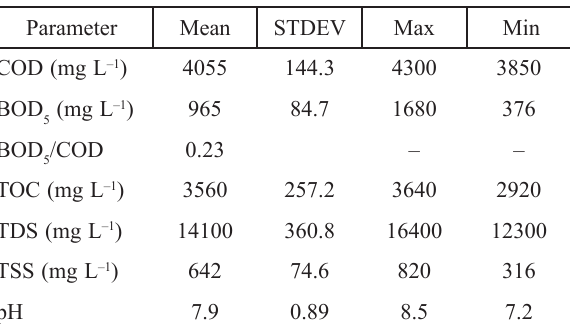
Table 1 – Characteristics of raw saline oily wastewater